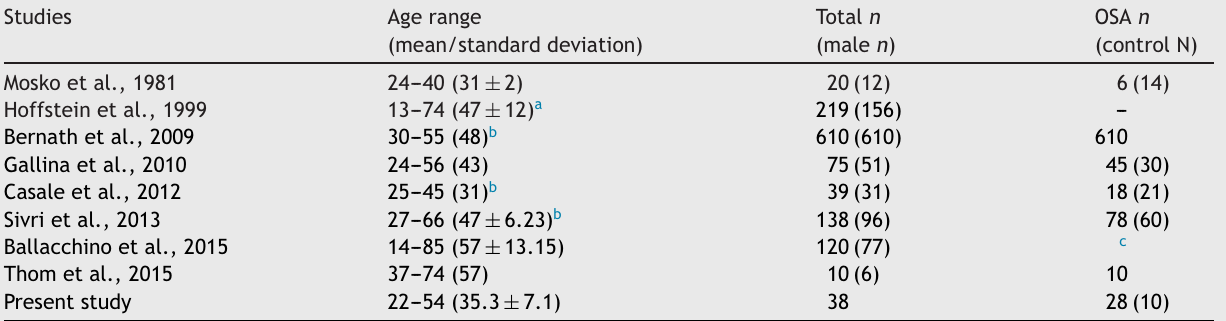
Present study 22---54 (35.3 ± 7.1) a Mean age and standard deviation of males with OSA. b Mean age of study group with